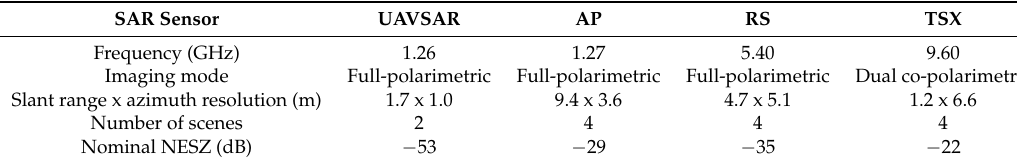
Table 1. General information on SAR imagery.